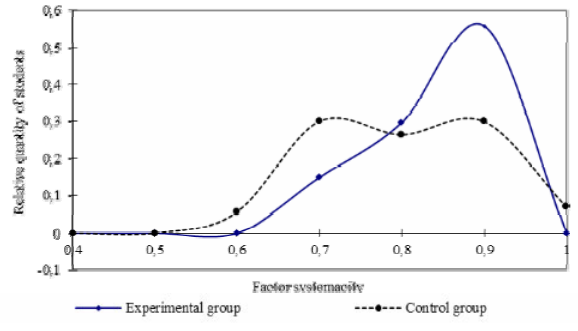
Figure 6. Density of students distribution by К